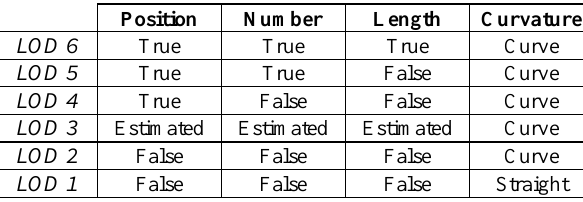
Table 7. Characteristics of each LOD of a 3D tree model of